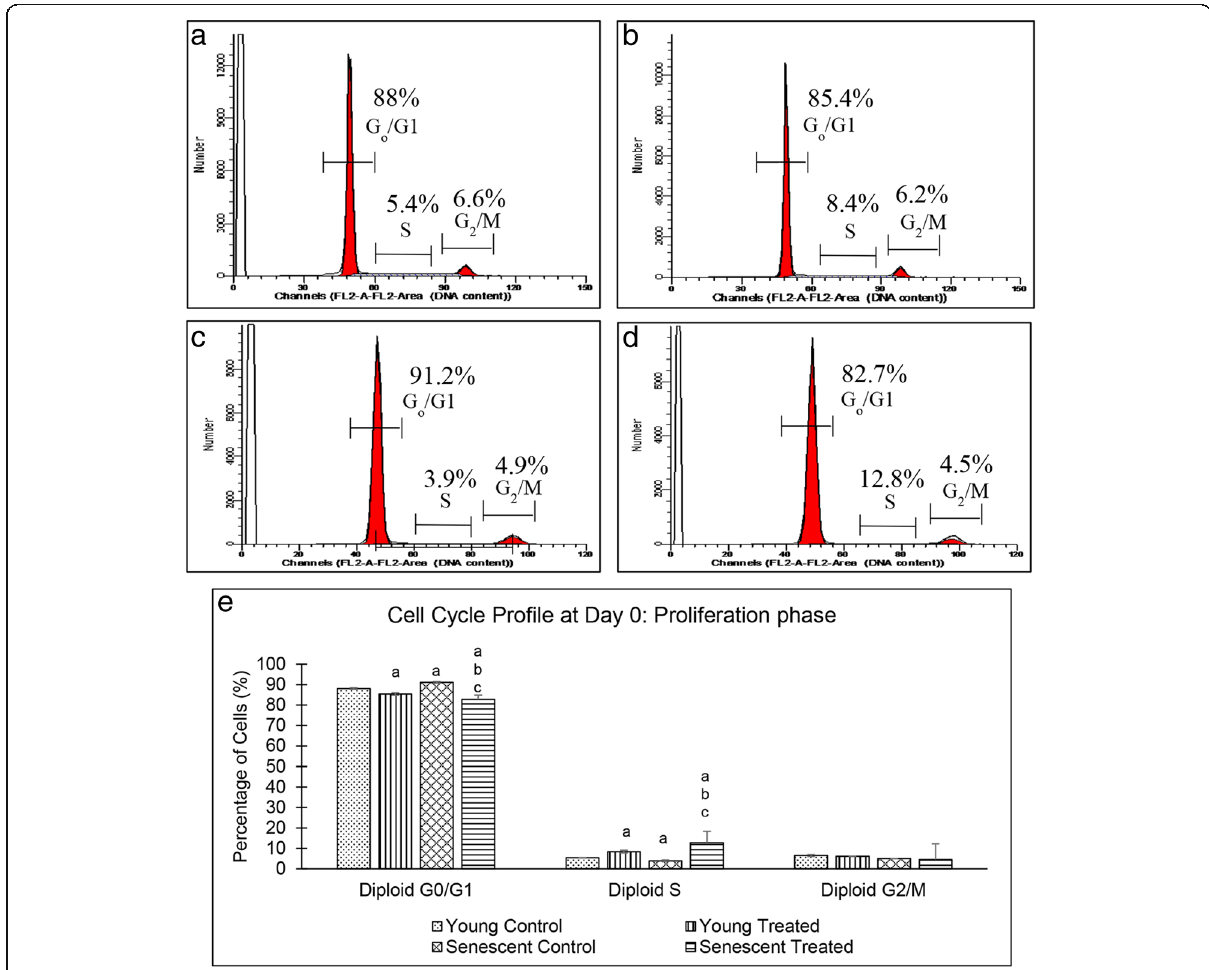
Fig. 6 Cell cycle profile of young and senescent myoblasts at day 0 of differentiation. Flow cytometry analysis of cell cycle progression of young control myoblasts ( a ), TRF-treated young myoblasts ( b ), senescent control myoblasts ( c ) and TRF-treated senescent myoblasts ( d ). Quantitative analysis of cell cycle progression of young and senescent myoblasts ( e ). a Denotes p < 0.05 compared to young control. b p < 0.05 compared to senescent control and c p < 0.05 compared to young treated group. Data are expressed as mean ± SD ( n =